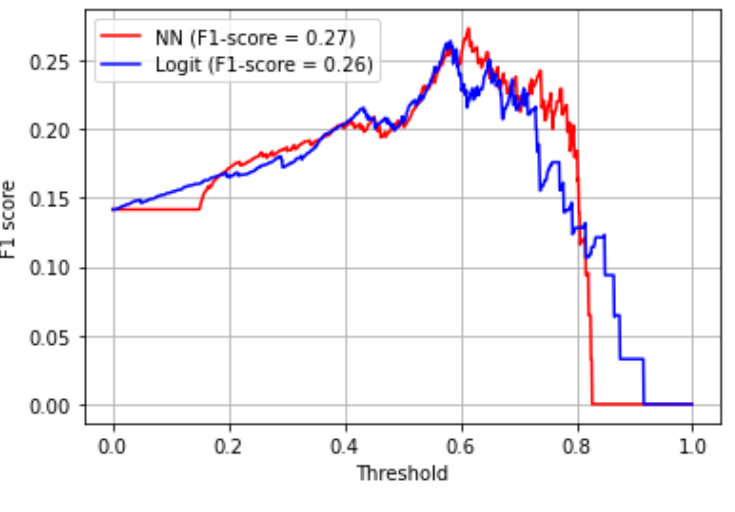
Figure 10. F1 score.